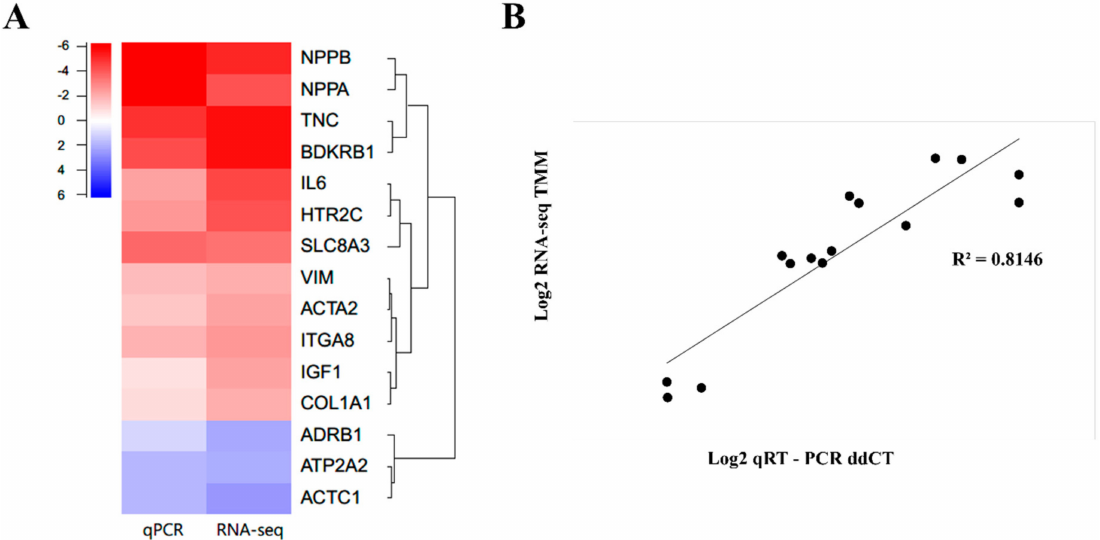
Figure 5. Validation of DEGs by qPCR. DEGs of XH across various biological pathways were verified using qRT-PCR. ( A ) Heat map showing the comparison of expression levels of qPCR vs. RNA sequencing. ( B ) Correlation analysis between XH and